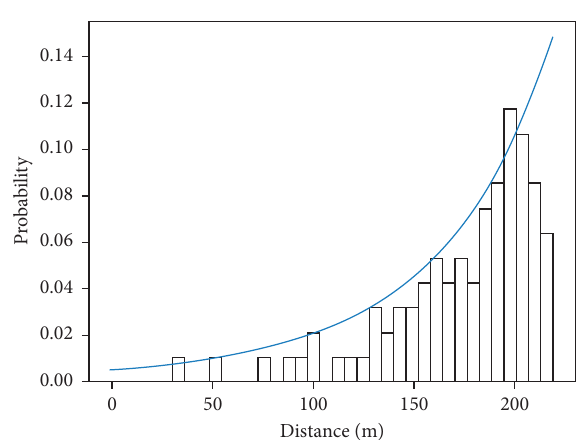
Figure 11: Histogram of lane-changing